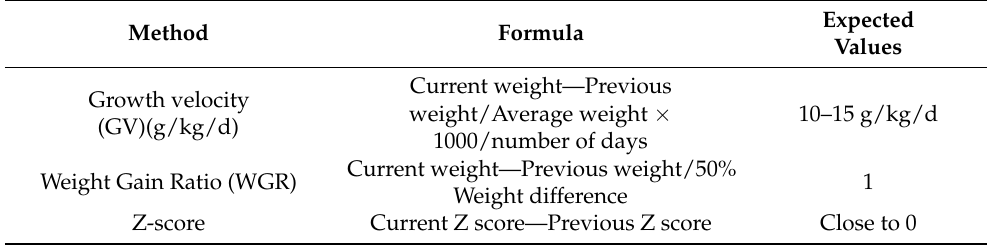
Table 1. Growth Monitoring Formulae [4,5].